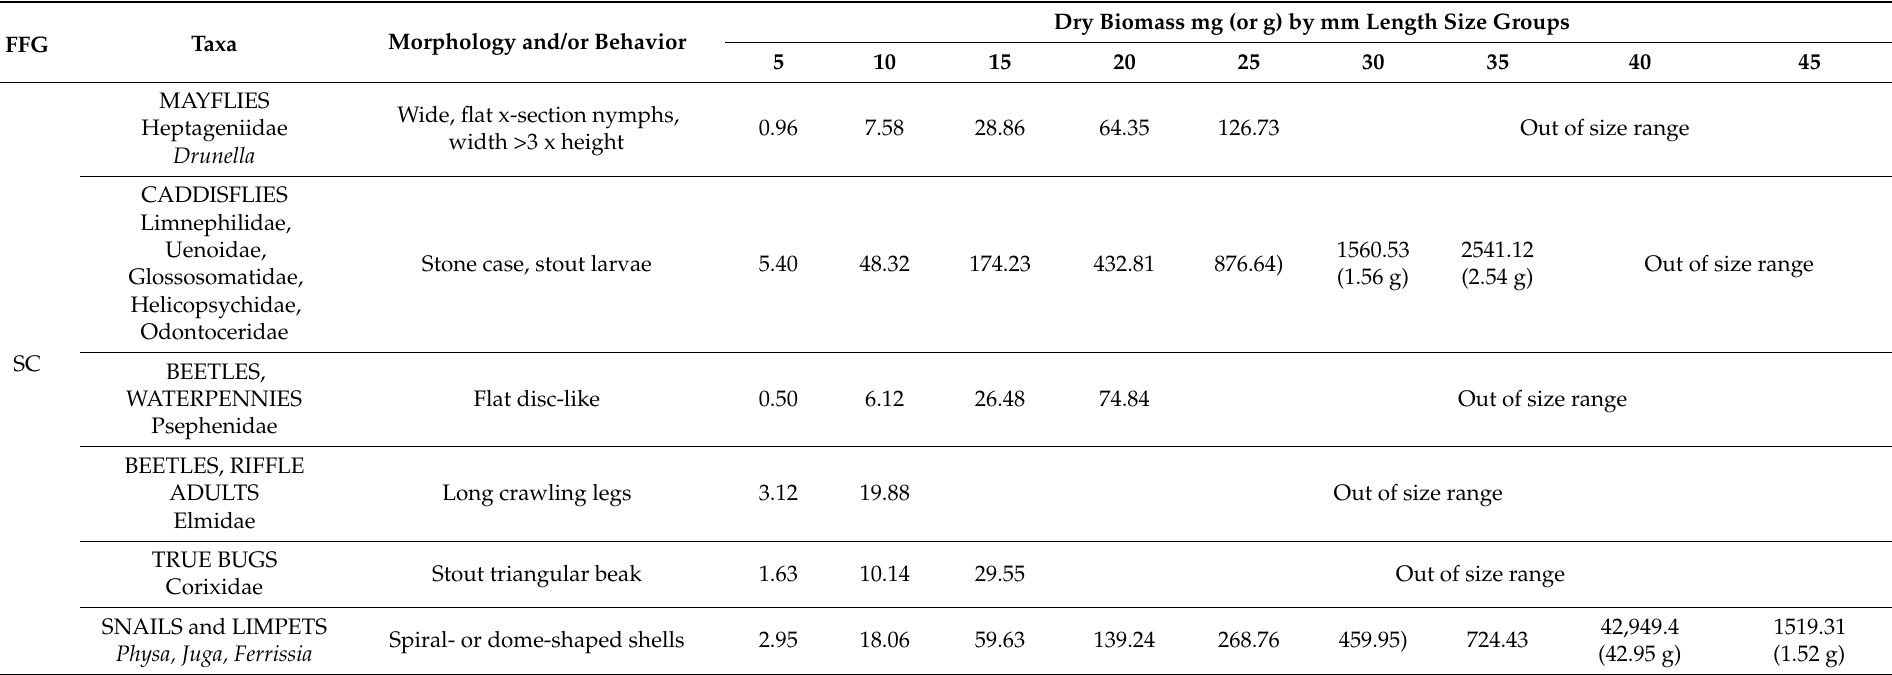
Table 3. Estimated dry mass per individual (mg) within length bins of 5 mm increments for each taxonomic category within its FFG. Estimates are based on averaged length–mass regression from the literature and the unpublished data of Cummins, at the midpoint of each size bin (e.g., at 7.5 mm for the >5 ≤ 10 mm bin). FFG = functional feeding groups; SC = scrapers; DSH = detrital shredders; GC = gathering collectors; FC = filtering collectors; P = predators; and HSH = herbivore shredders. Estimates are based on the relationship W = aL b , where W = dry biomass in mg; L = length in mm; and a = W intercept and b = slope of the relationship of W on L. Oligochaeta biomass based on constant (a) times the total length (L) of all worm segments in a sample as W: aL. Blank spaces indicate that the estimated dry biomass is out of the normal size range based on the